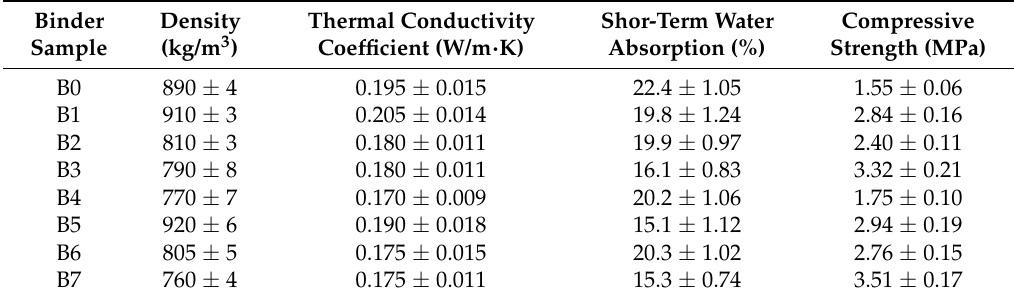
Table 3. Physical characteristics and compressive strength of 28-day hardened bio-composites.